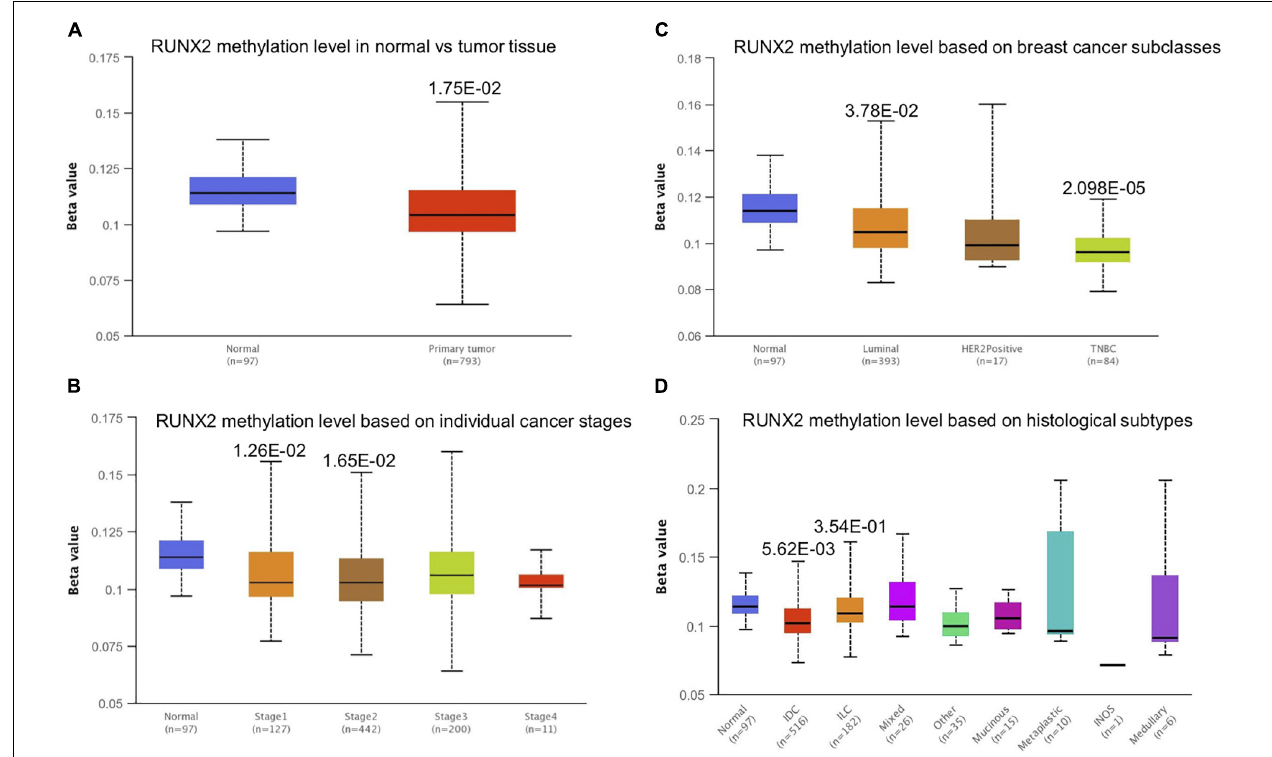
FIGURE 8 | Correlation analysis between RUNX2 methylation level and breast cancer patient characteristics. The RUNX2 methylation level in breast cancer patients classified by (A) sample types, (B) individual cancer stages, (C) breast cancer subclasses, and (D) histological subtypes were